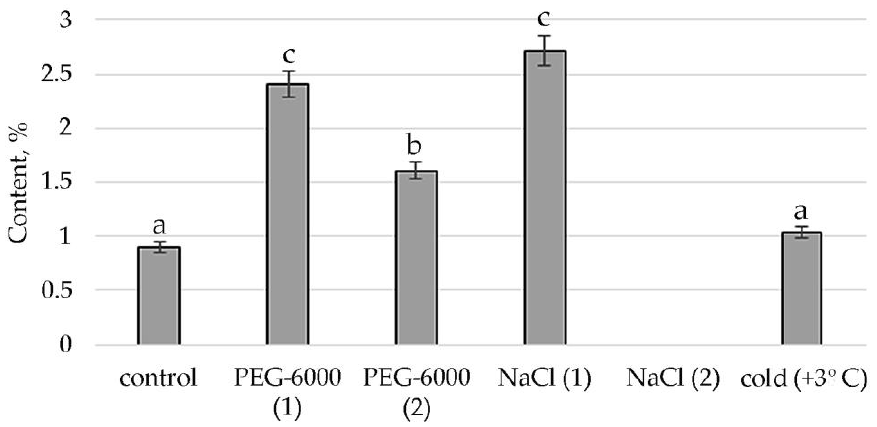
Figure 8. Change in content of 1,4-Benzenediol, 2,5-bis(1,1-dimethylethyl)- in S. hybridum under stress conditions. Values presented are means (±SD). Different letters above the bars represent significant differences at p ≤ 0.05, n = 3 plants in each of 3 replicates for all treatments. Therefore, according to the structural group composition of the ethanol extract of S.